Question: Which visualization type does this figure use?
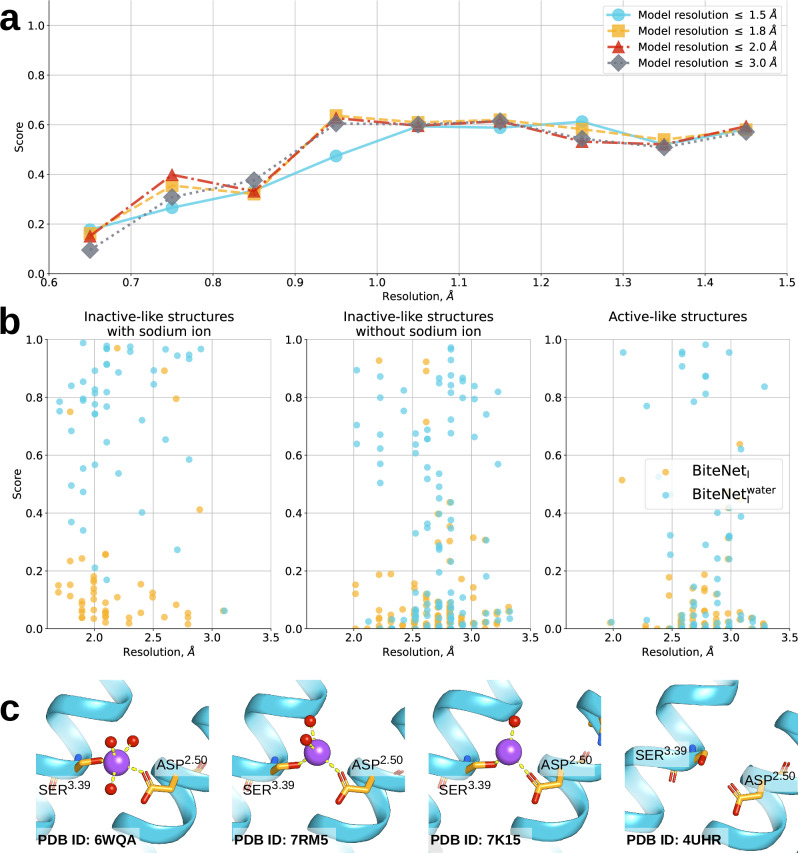
Answer: scatter